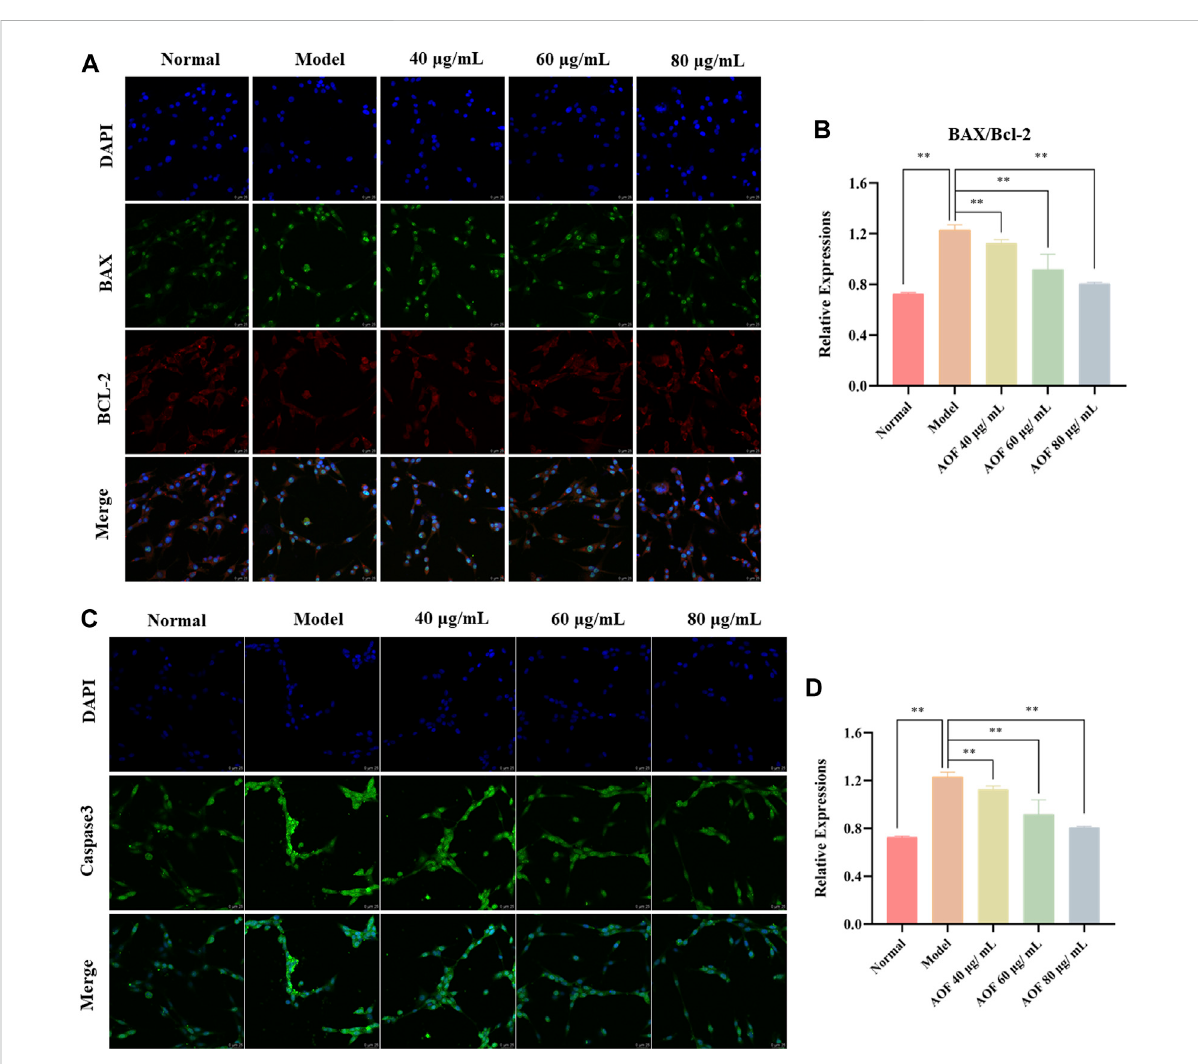
FIGURE 11 Effects of AOF on apoptosis proteins in H 2 O 2 -stimulated PC12 cells (A) IF images of Bcl-2 and Bax (B) Analysis of the Bcl-2/Bax ratio (C) IF images of Caspase-3 (D) Analysis of the Caspase-3. Data were expressed as mean ± SD ( n = 3), ** p < 0.01 vs